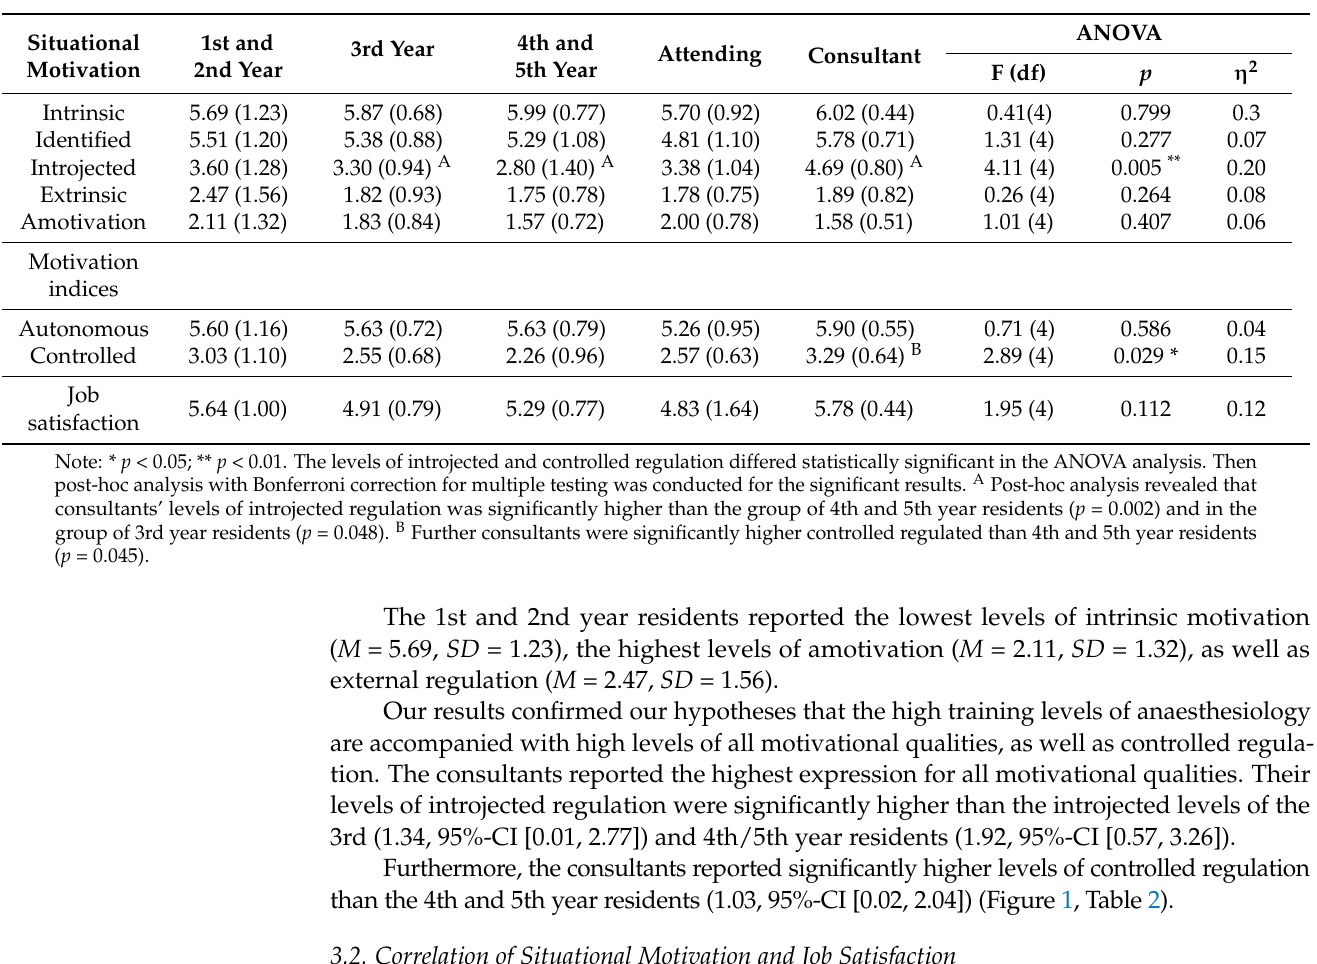
Table 2. Internal consistency means (standard deviation) of different situational motivational variables and job satisfaction